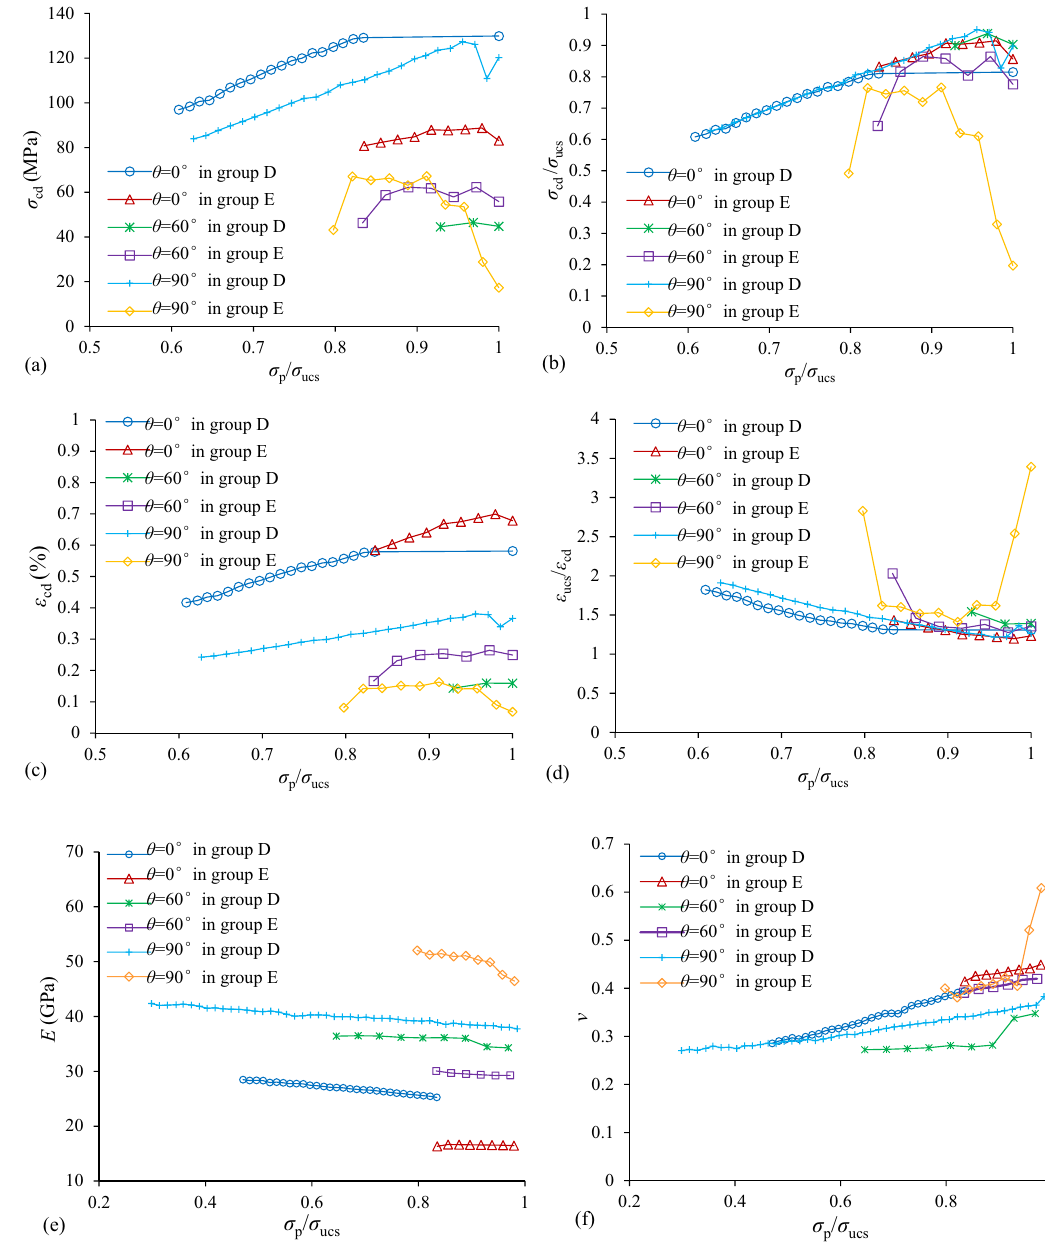
Figure 7. Evolution of ( a ) σ cd , ( b ) σ cd / σ ucs , ( c ) ε cd , ( d ) ε ucs / ε cd , ( e ) E and ( f ) ν for different shale specimens as σ p / σ ucs in ascending the largest. Figure 7f shows that the ν were in ascending order as the dynamic load increased. For the loading type of group D, the values of ν of specimens with θ = 90° were larger than those of θ = 60° and smaller than those of θ = 0°. For the loading type of group E, the values of ν of specimens among θ = 0°, θ = 60° and θ = 90° were almost the same except the values of ν of specimens with θ = 90° increased significantly at last two loading cycles. During cycle loading process, if it assumed that there was no heat exchange, the compression energy was transferred to elastic strain energy ( U e ) and dissipated energy ( U irr ). U e related to the unloading elastic modulus E , was defined as the work done by stress and strain, equalling to the area between the unloading curve and ε- axis as shown in Fig. 8. It was recoverable after unloading. U irr was defined as the irreversible work for a loading and unloading cycle which was primarily induced by micro-crack initiation, propagation and coalescence. Figure 8 shows that it equals to the area of the shape confined by the loading, unloading curves and ε- axis in each loading cycle. Figure 9 indicates that the changes of U e and U irr of each cycle for all specimens in group D and E was a function of the normalized stress ( σ p / σ ucs ) in each loading cycle. U e significantly increased as σ p / σ ucs increased, while U irr had a descending order at the first loading cycle as well as increased in following cycles. The mean U e was larger than that of U irr .